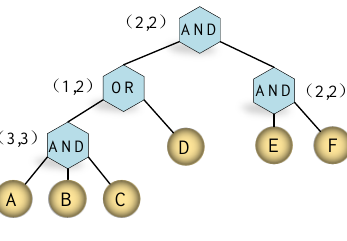
Figure 1. Access Tree Structure.